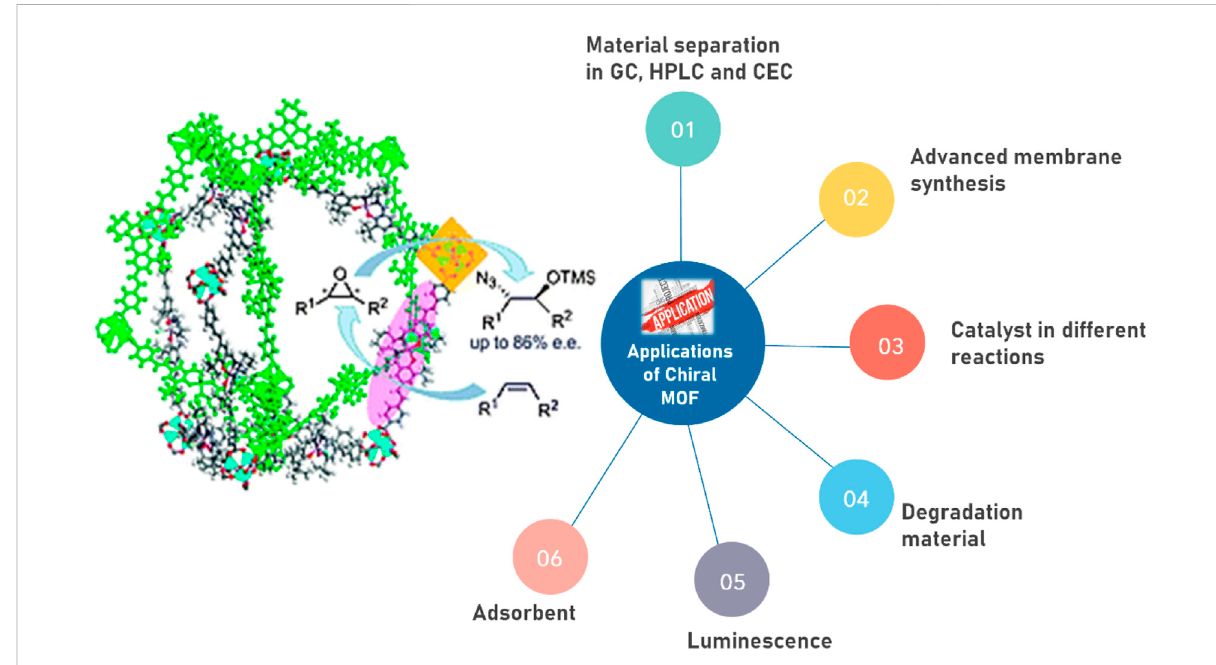
FIGURE 5 Applications of Chiral MOFs exhibiting multiple advantages of chiral MOFs in many fi elds of